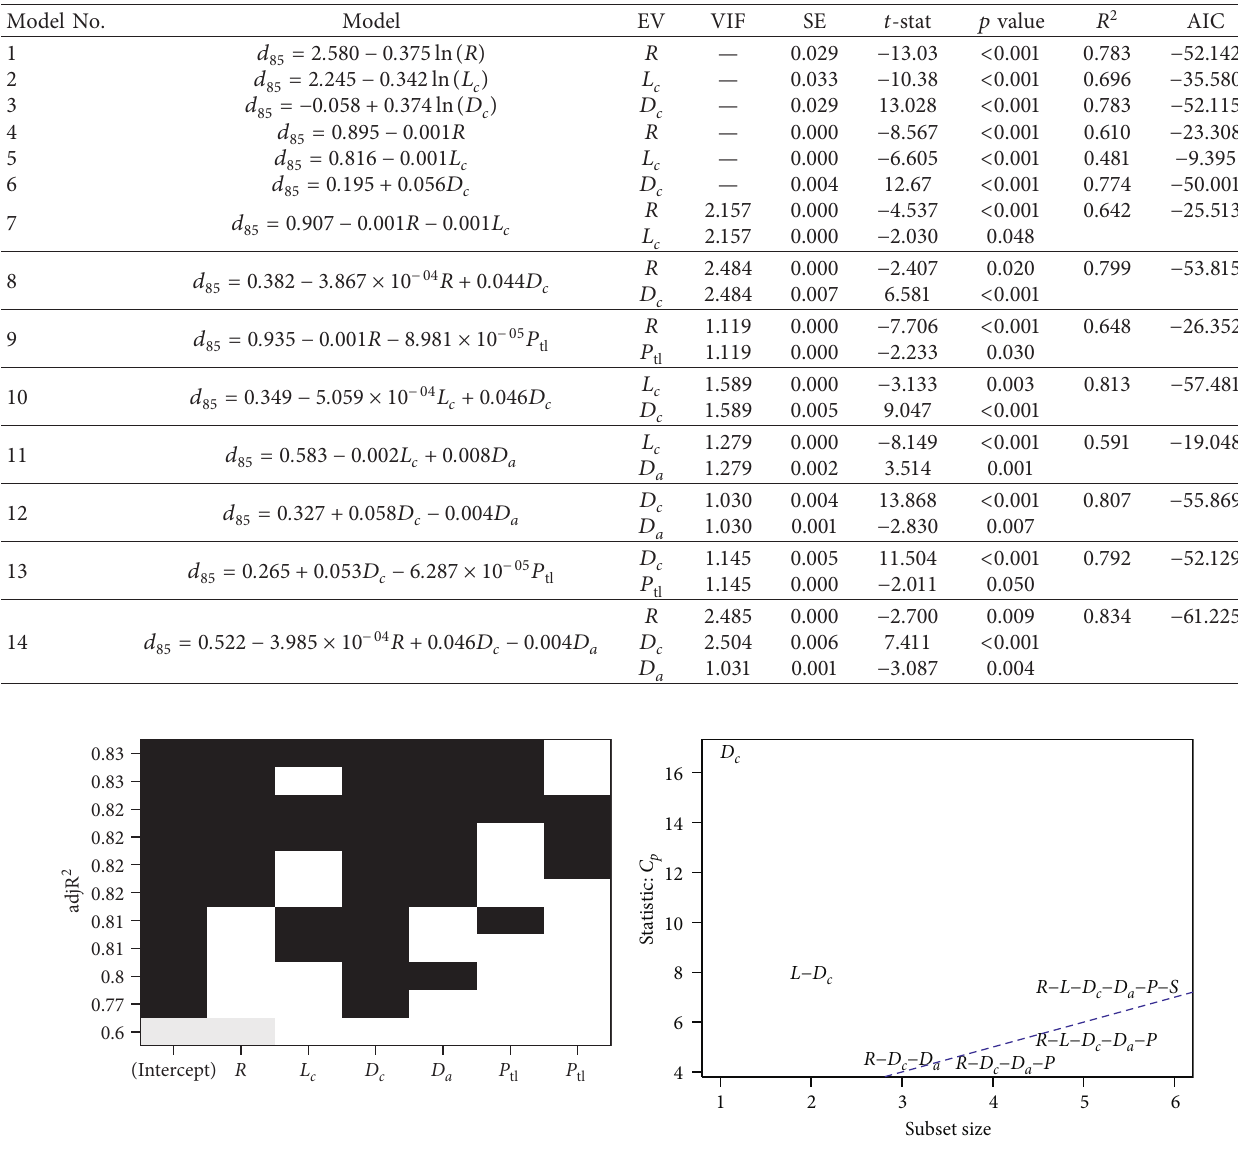
Table 10: Summary of analysis results for 85 th percentile deceleration rate models. Model No.